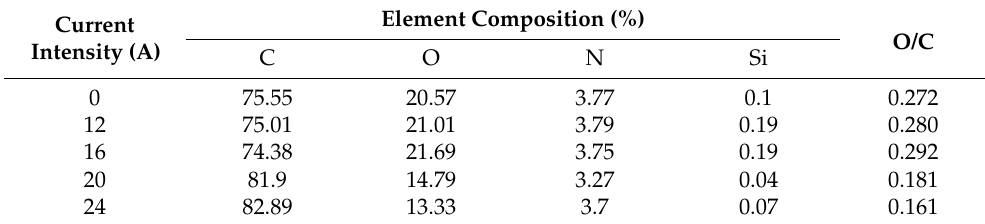
Table 1. Analysis of chemical elements on the CF surface.